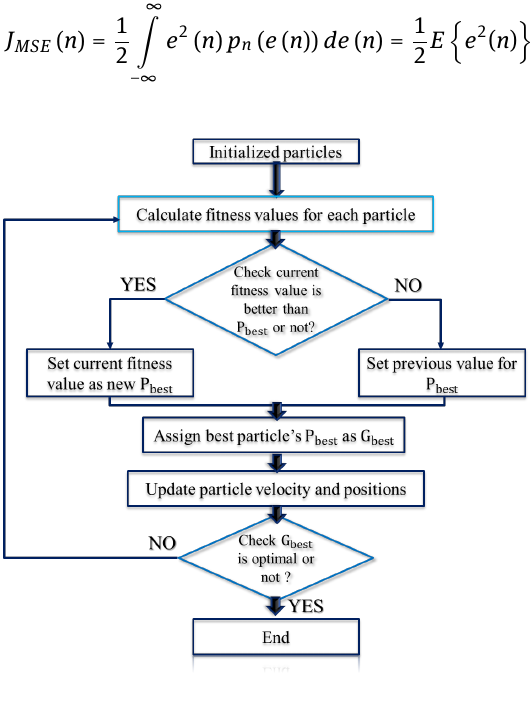
Figure 7: Flow chart for